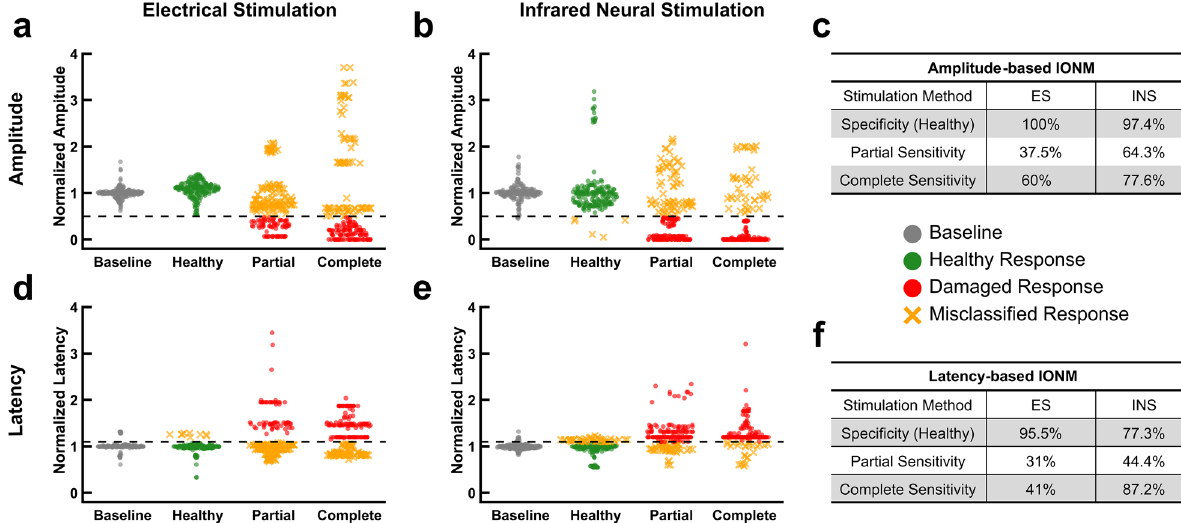
Figure 3. Stretch injuries are revealed with similar efficacy using both electrical and infrared neural stimulation. ( a ) Normalized CMAP amplitudes resulting from ES in baseline, healthy, partial stretch, and complete stretch conditions. Black dashed line represents the amplitude damage threshold (50% decrease). ( b ) Normalized CMAP amplitudes resulting from INS in baseline, healthy, partial stretch, and complete stretch conditions. ( c ) Sensitivity and specificity for the amplitude-based IONM approach to stretch injuries. ( d ) Normalized CMAP latencies resulting from ES in baseline, healthy, partial stretch, and complete stretch conditions. Black dashed line represents the latency damage threshold (10% increase). If no CMAP was evoked latency was set to 1.2 for ease of visual interpretation. ( e ) Normalized CMAP latencies resulting from INS in baseline, healthy, partial stretch, and complete stretch conditions. Note: Six normalized latency outliers in the partial stretch condition exceeded 4 (12–97) and were not plotted for better visualization. ( f ) Sensitivity and specificity for the latency-based IONM approach to stretch injuries. Specificity in all cases was calculated using the ‘Healthy’ category of responses. All data is normalized to the mean baseline values for each individual nerve. n = 10 nerves for all data sets (5